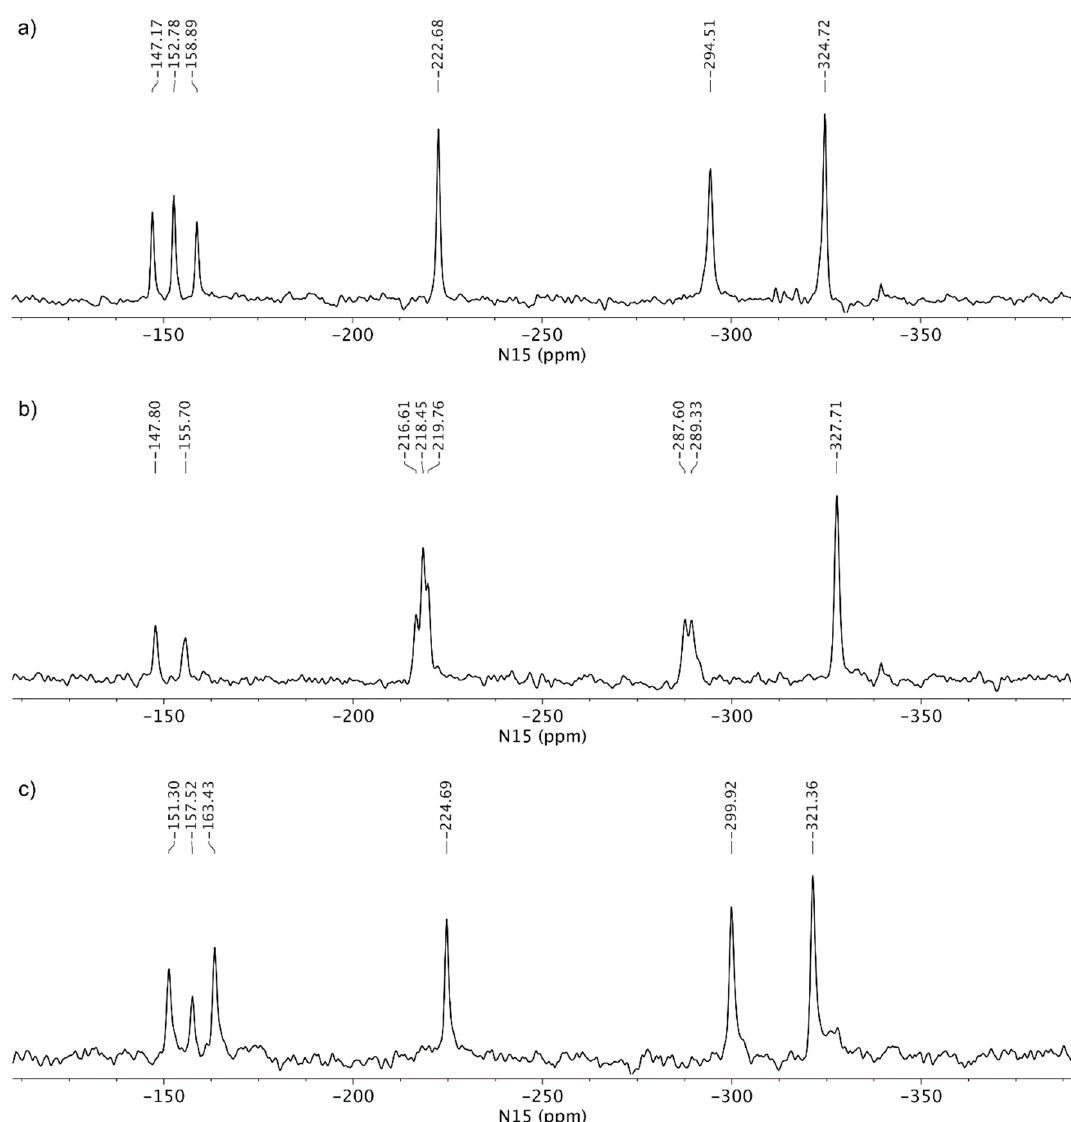
Figure 6. 15 N CP MAS NMR ( 15 N cross-polarization magic angle spinning nuclear magnetic resonance) spectra of ( a ) TA, ( b ) TA HCl and ( c ) TA HF.